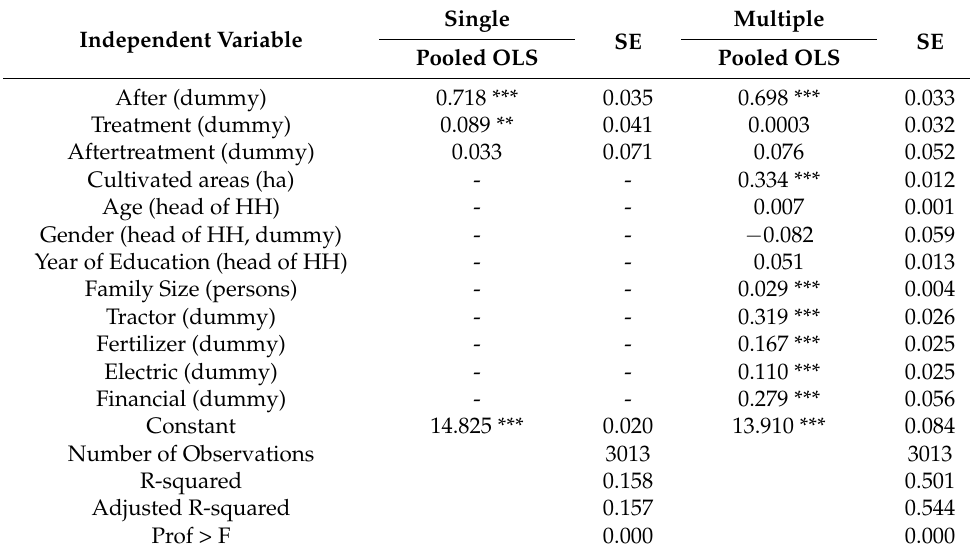
Table 7. The DID estimated by single and multiple pooled OLS of the effect on log total income. Independent